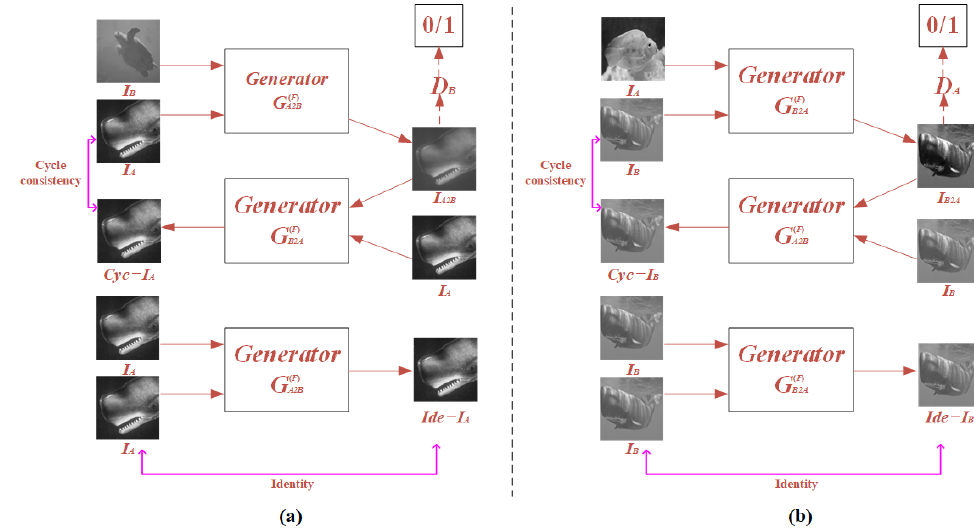
Figure 2. Schematic of FUIGN.